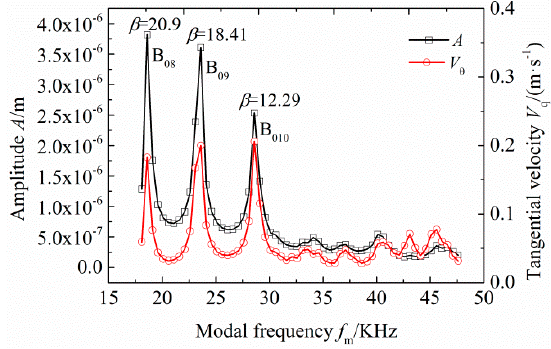
Figure 9. Simulation curves of the stator vibration parameters of 70HB.